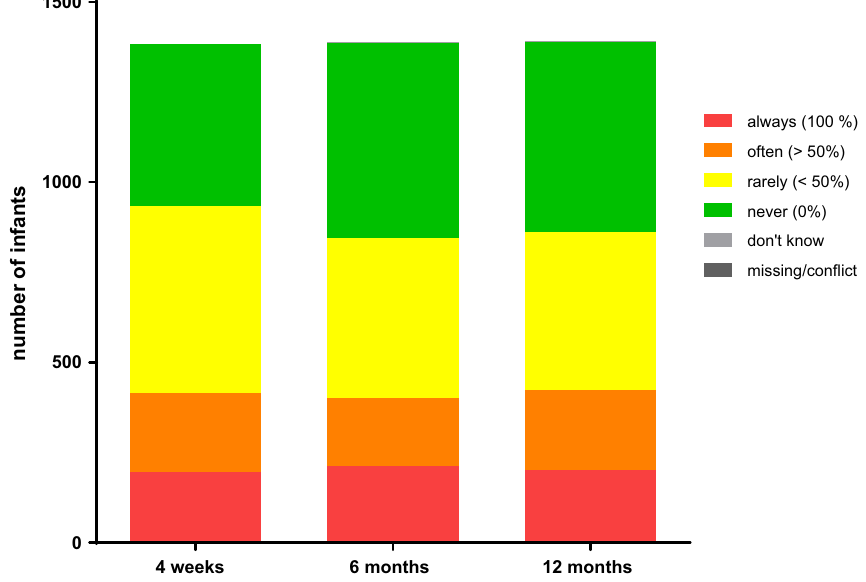
Figure 3. Frequency of bed-sharing (“ How often does your infant co-sleep with an adult in one bed at the same time?